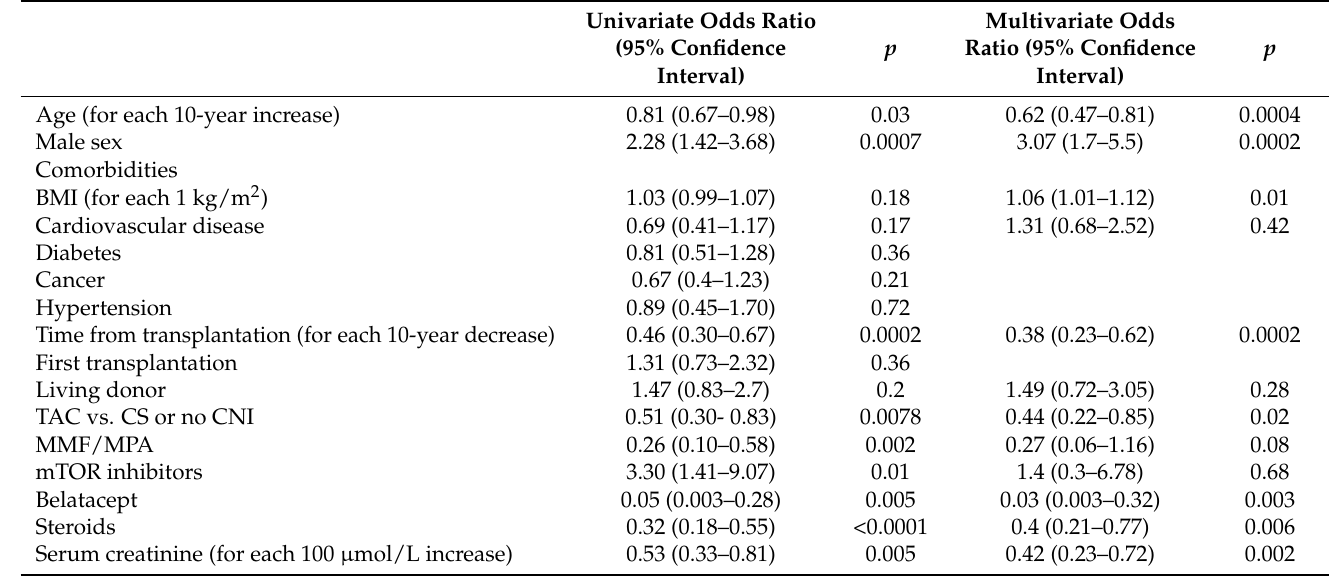
Table 5. Univariate and multivariate analysis of predictors factors for seroconversion after three vaccine